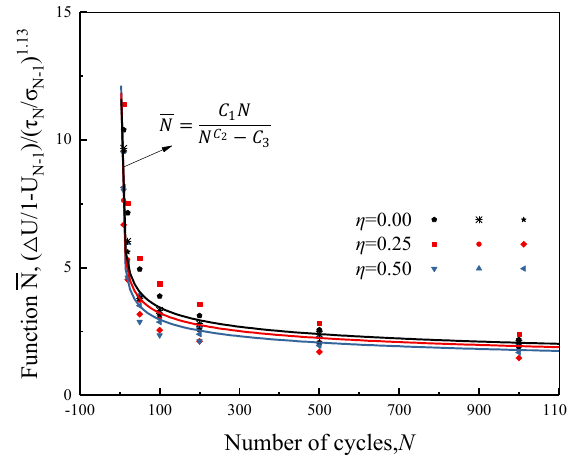
Figure 7. Cycles and functions 𝑁 .